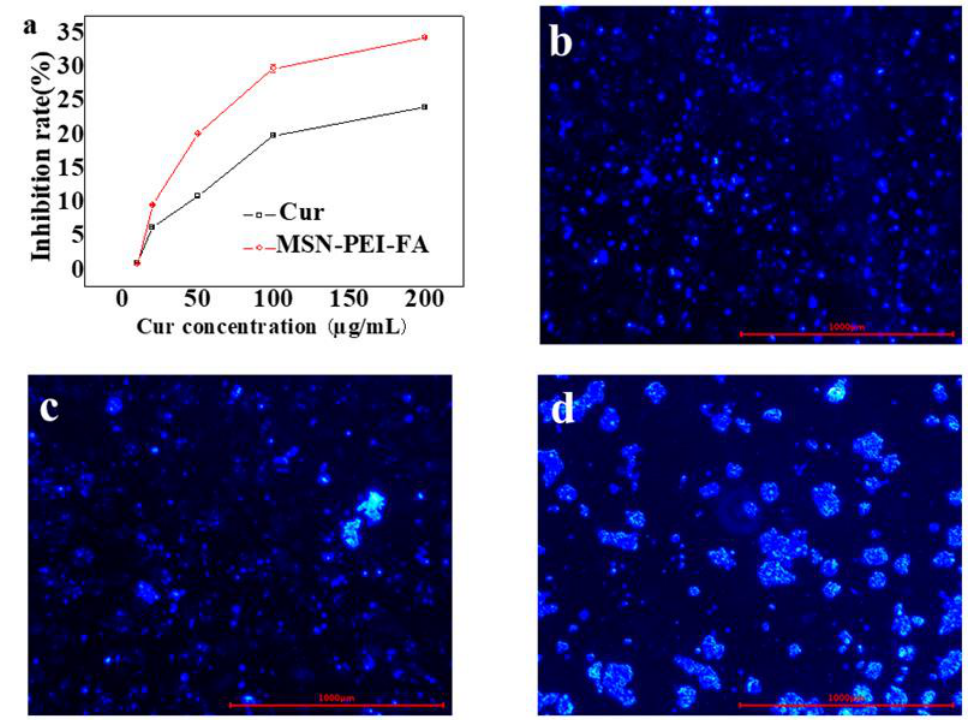
Figure 6. ( a ) Inhibition rate of Cur and MSN-PEI-FA/Cur; fluorescence microscopic images of LS174T for coumarin-loaded MSN ( b ), MSN–PEI ( c ), and MSN–PEI-FA ( d ) intake experiments. “The MTT method was used to evaluate the cytotoxicity of MSN-PEI-FA/Cur on colon cancer cells. MSN-PEI-FA/Cur solution of concentrations of 10–200 µg/mL was prepared in PBS”. The authors would like to apologize for any inconvenience caused to the readers by these changes.